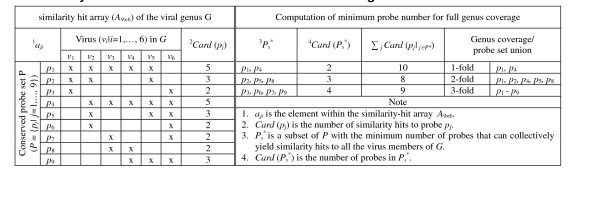
Table 1 - Example searching the minimum number of probes that generate similarity hits with all the virus members within a viral genus.